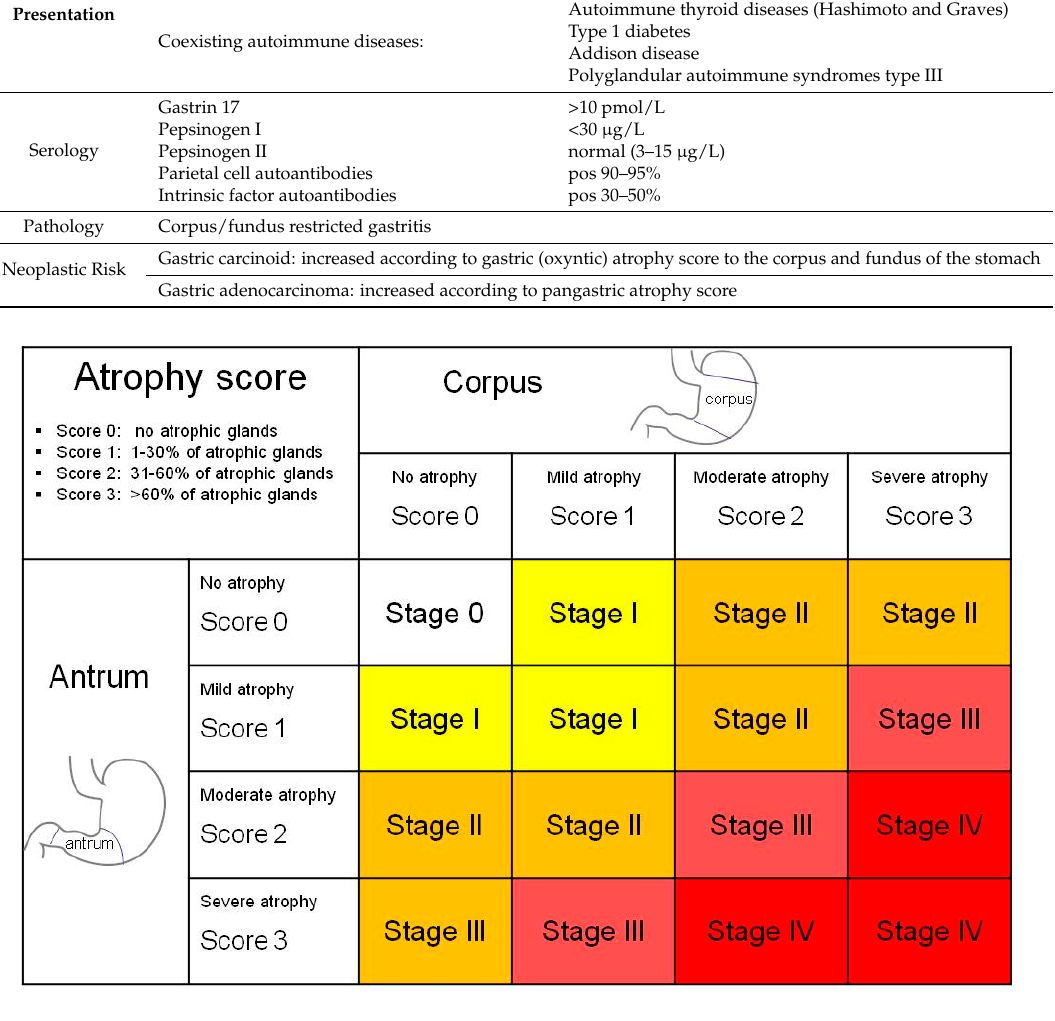
Figure 1. OLGA (operative link for gastritis assessment) staging system for gastritis. Modified from Rugge M. et al. [65]. Table 1. Clinical presentation, serology, pathology and neoplastic risk of autoimmune gastritis.